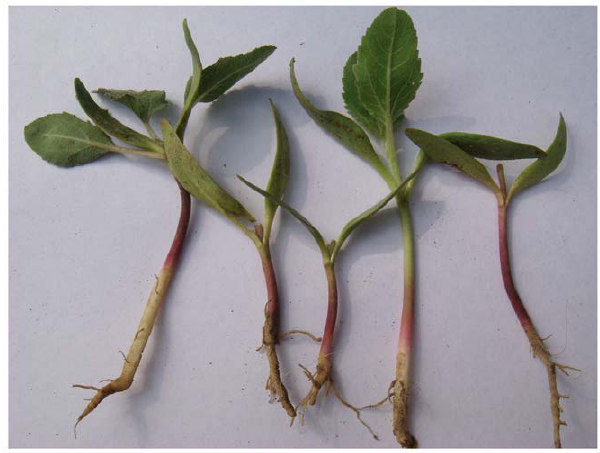
Figure 3. Ghagrashak ( Xanthiumstrumarium ) plants picked from the index village during the outbreak.